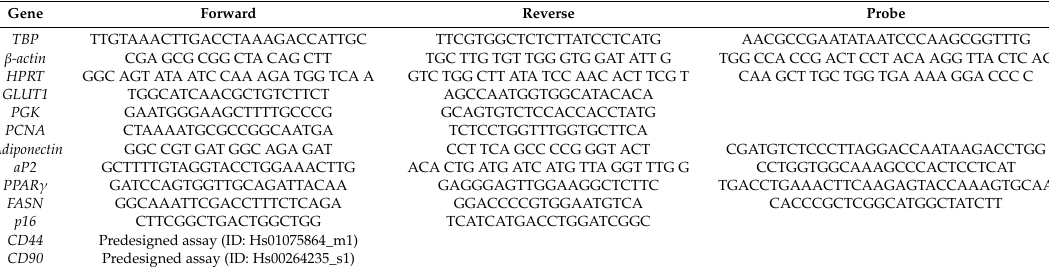
Table 3. Primers used for